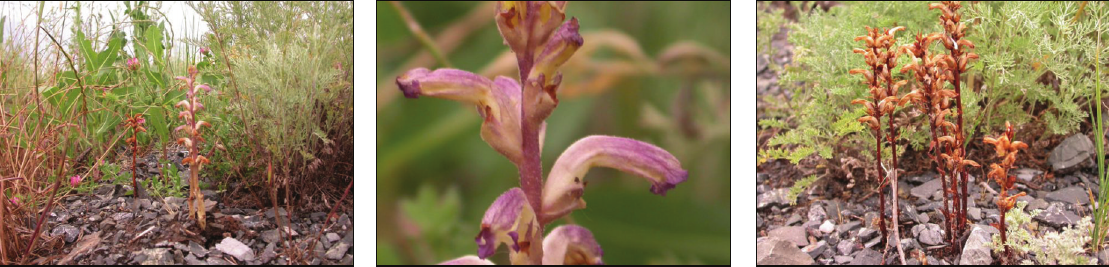
Figure 2: Details of population CUMBUL-1 of Orobanche cumana parasitizing Artemisia maritima in Burgas,